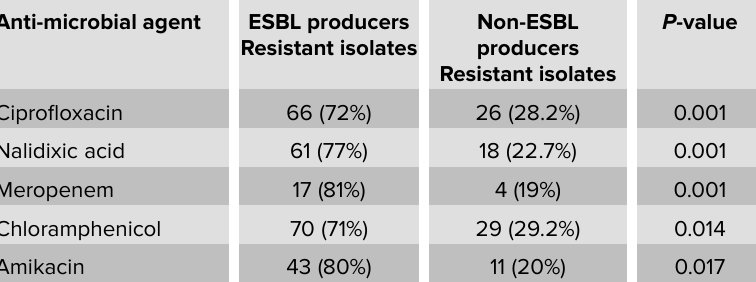
TABLE 2: The association between antibiotic resistance and ESBLs-producing and non-ESBLs-producing